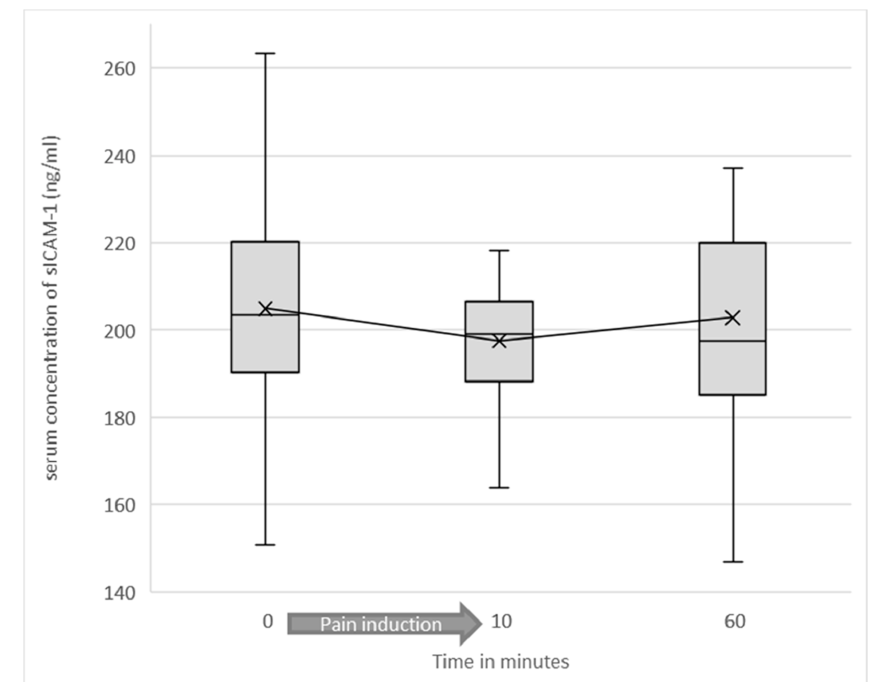
Figure 2. Soluble ICAM-1 serum concentrations as a function of test duration among all test participants are shown as a box plot diagram. Outliers are not shown. The difference in mean sICAM-1 concentration before and immediately after induction of pain was statistically significant ( p = 0.003).